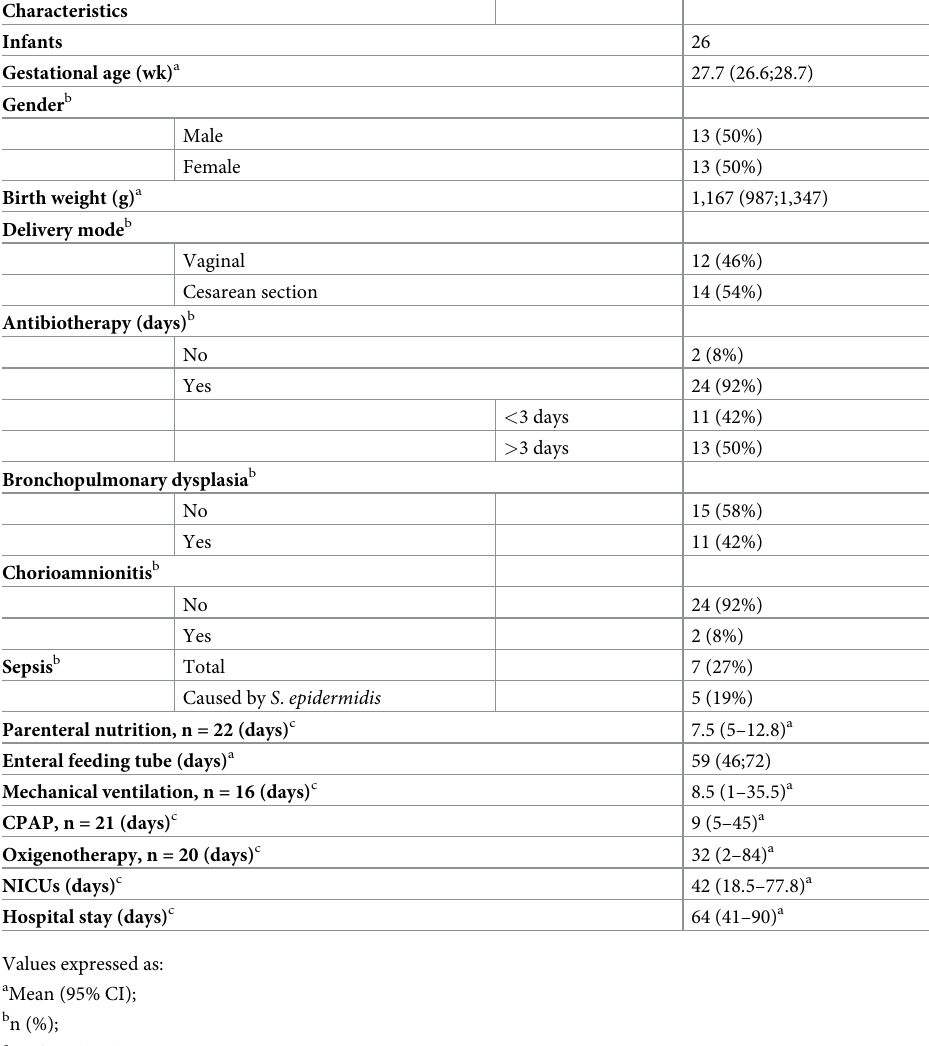
Table 1. Demographic data and clinical characteristics of the preterm infants participating this study.